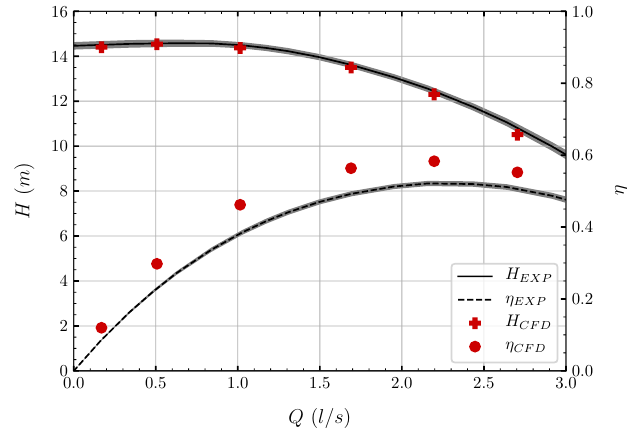
Figure 8. Head and efficiency as a function of the flow rate for Case 1sp.